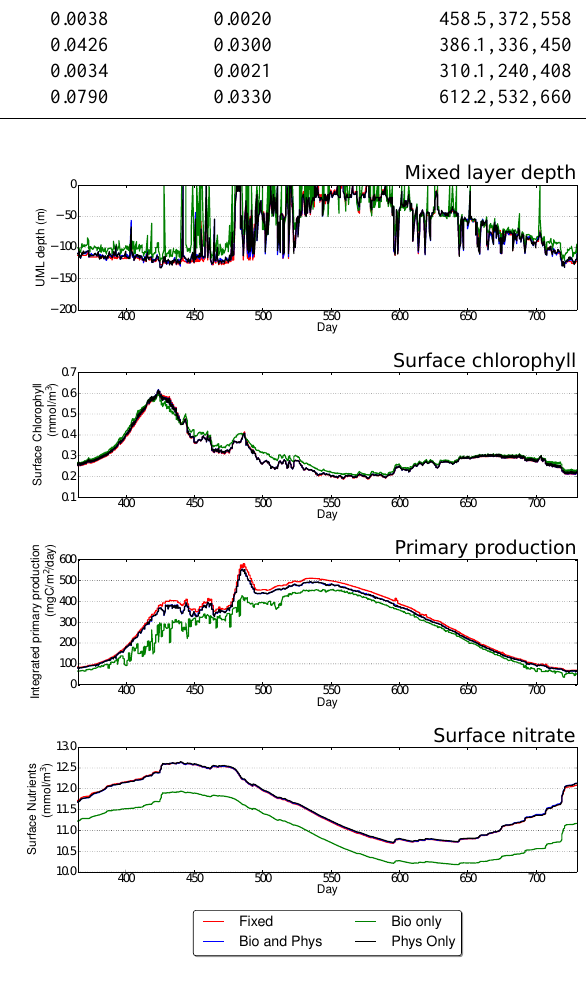
Fig. 12. Summary of results comparing different adaptivity metrics against measured data and the high-resolution (2.5m) fixed-mesh simulation for Station